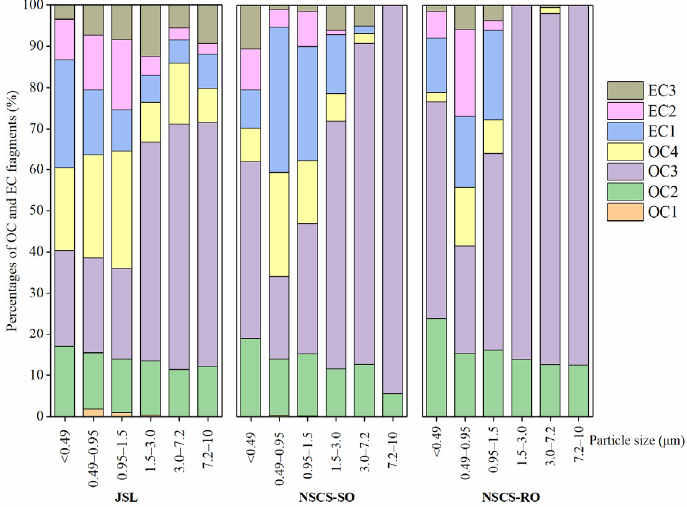
Figure 6. Percentages of OC and EC fragments in di ff erent particle-size bins.